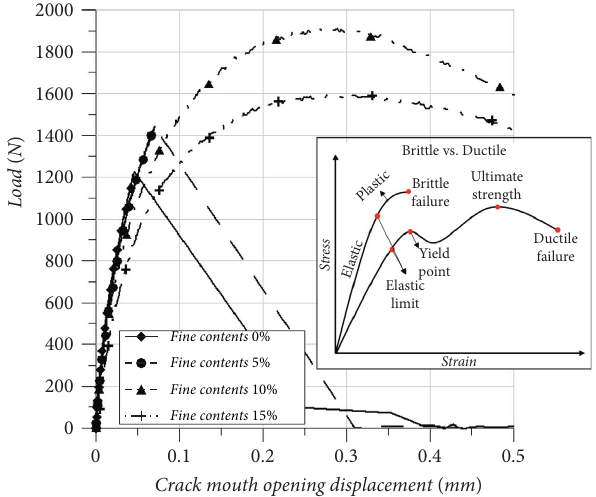
Figure 13: Enlarged load-CMOD curves of frozen specimen at − 10 °